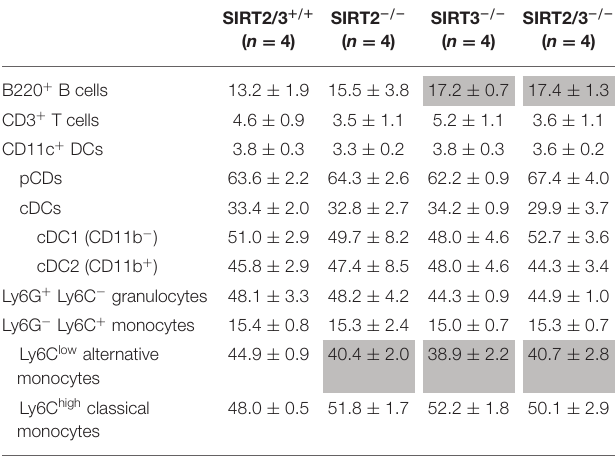
TABLE 1 | Bone marrow cell subsets.